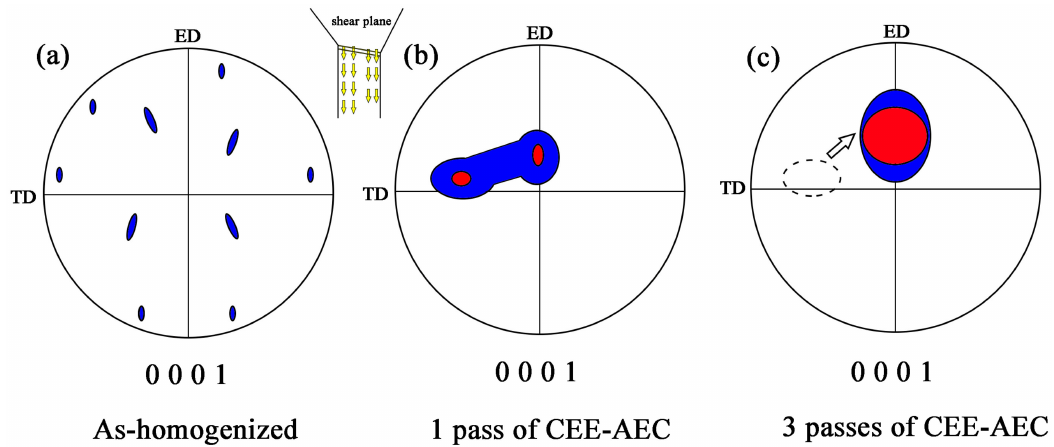
Figure 13. Schematic illustration of the dominant textures during CEE-AEC: ( a ) the as-homogenized; ( b ) 1 pass of CEE-AEC; ( c ) 3 passes of